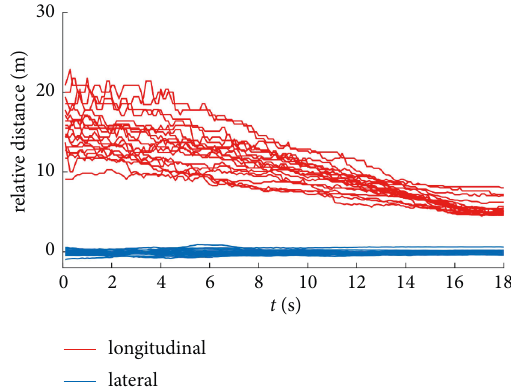
Figure 4: Ranging effect for drivers following a car to stop at